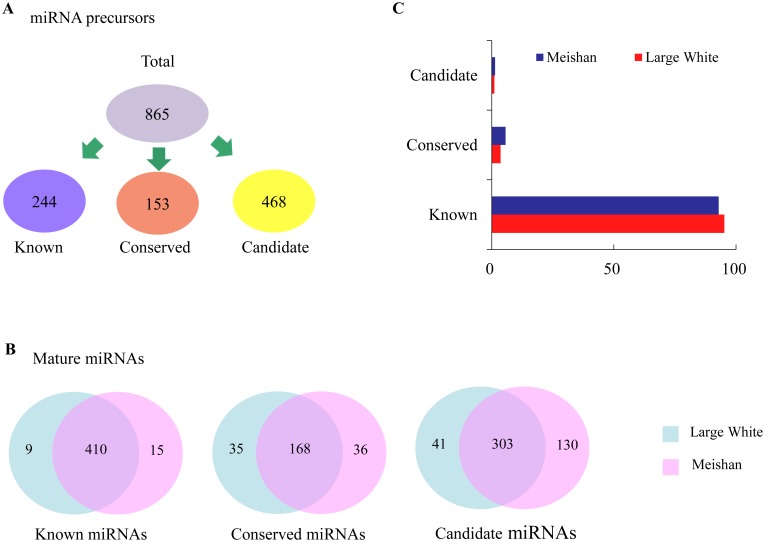
Description of miRNAs in two pig breeds.(A) Overview of the miRNA precursors including known, conserved and candidate miRNAs between Large White (LW) and Meishan (MS). (B) Venn charts indicate expression patterns of known, conserved and candidate miRNAs. (C) Distribution of read counts between LW and MS.